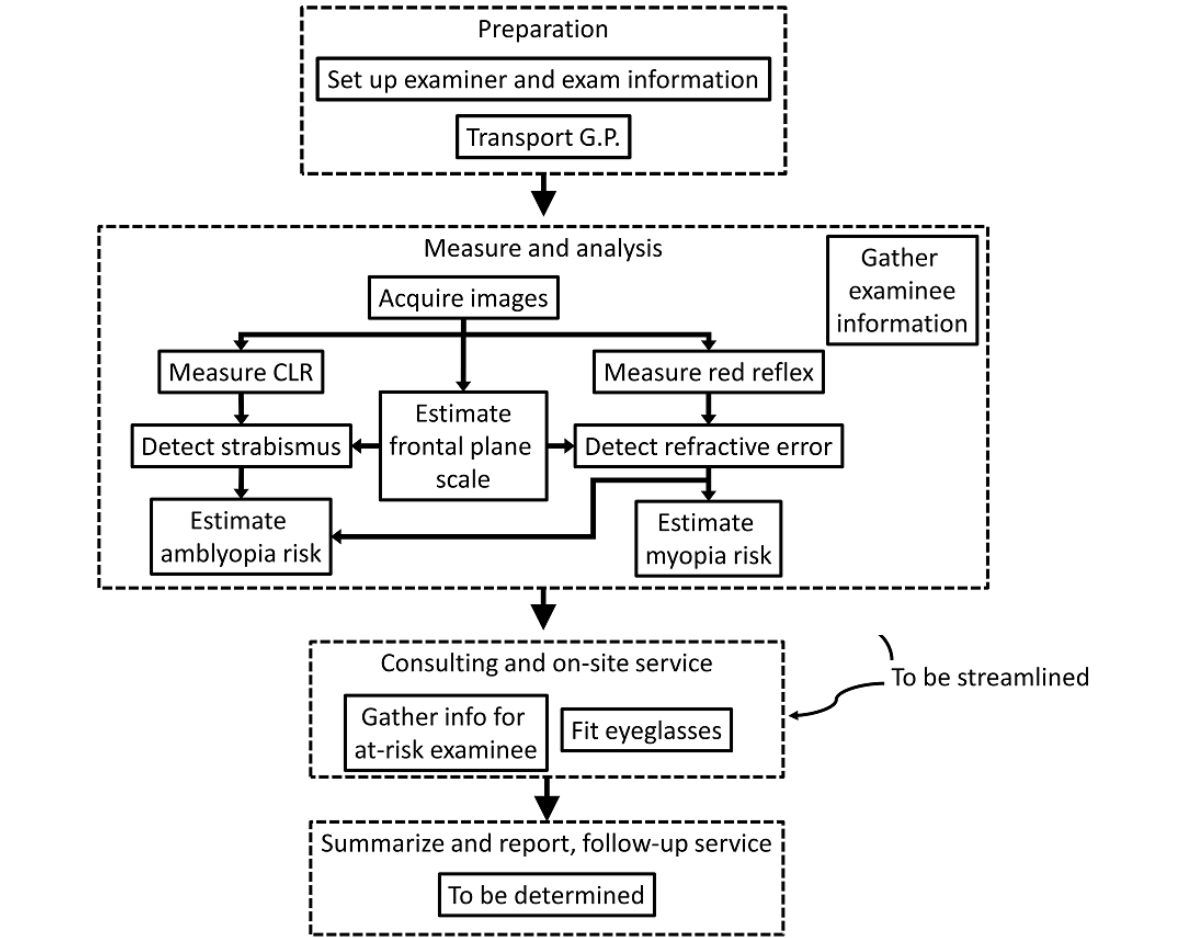
Figure 5. System outline. CLR: corneal luminous reflection; G.P.: general practitioner.